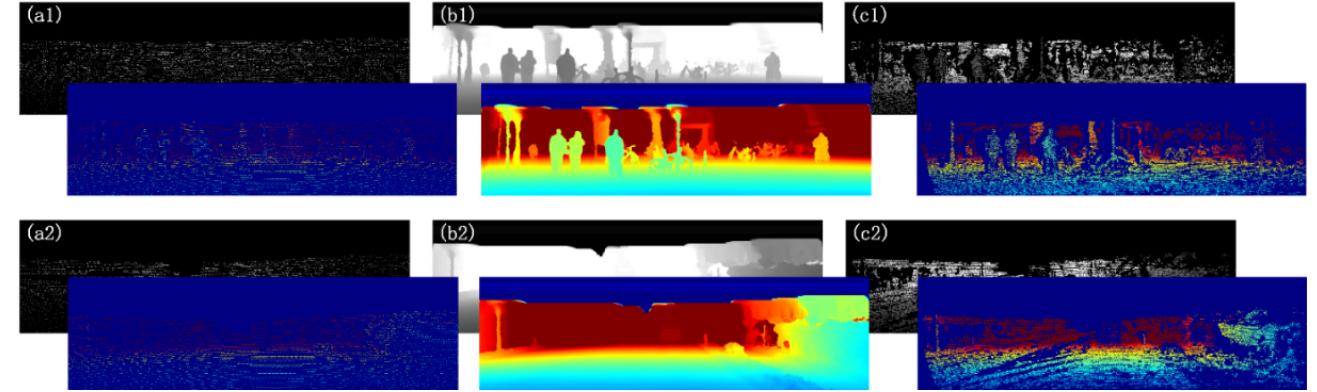
Figure 5. The complete results of our network on KITTI. ( a ) is the input sparse depth image. ( b ) is the completed depth image we output. ( c ) is the ground truth.